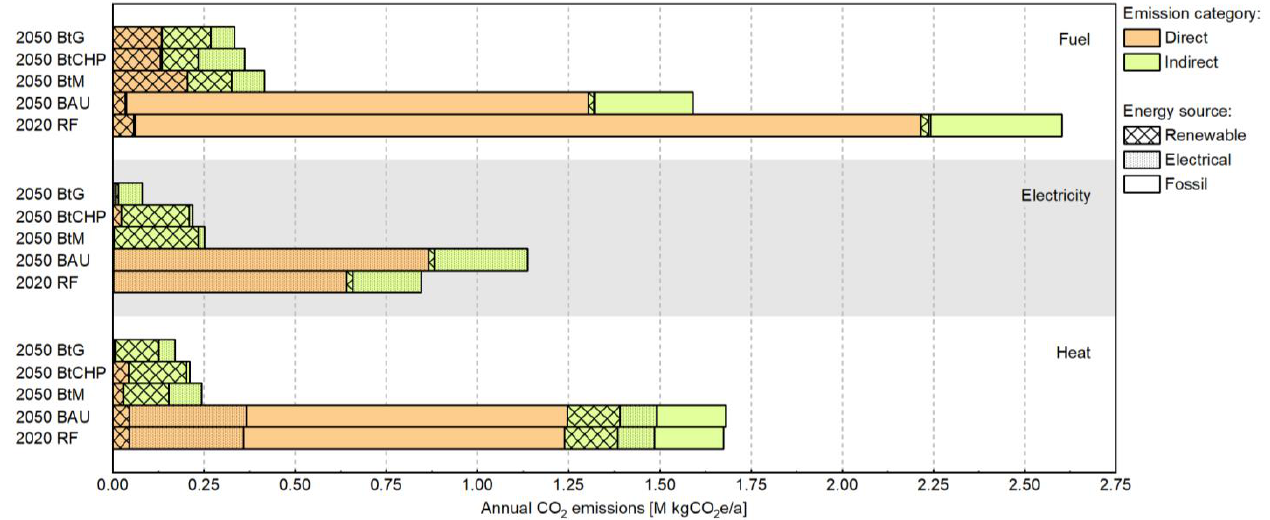
Figure 9. Comparison of annual CO 2 e emissions of the reference case (2020) with assumed scenarios (2050).